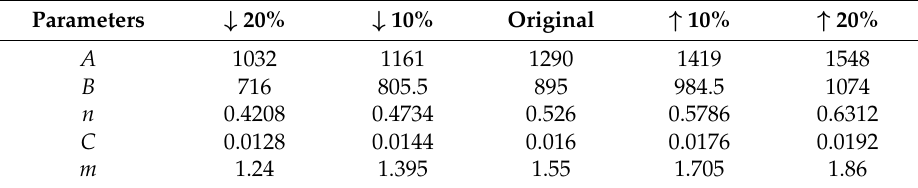
Table 4. The researched scope of constitutive parameters for Inconel